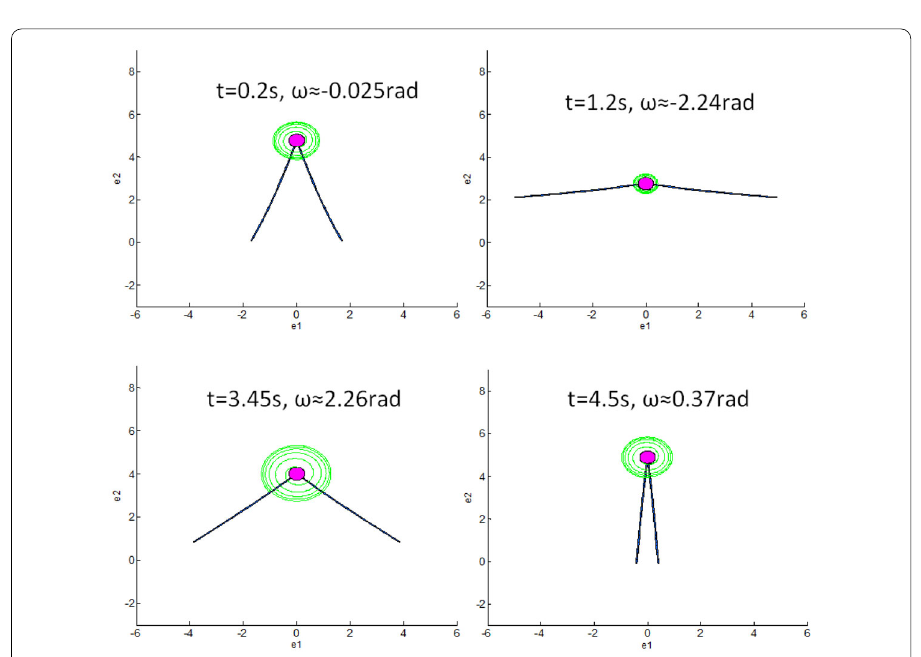
Fig. 27 Multi-body